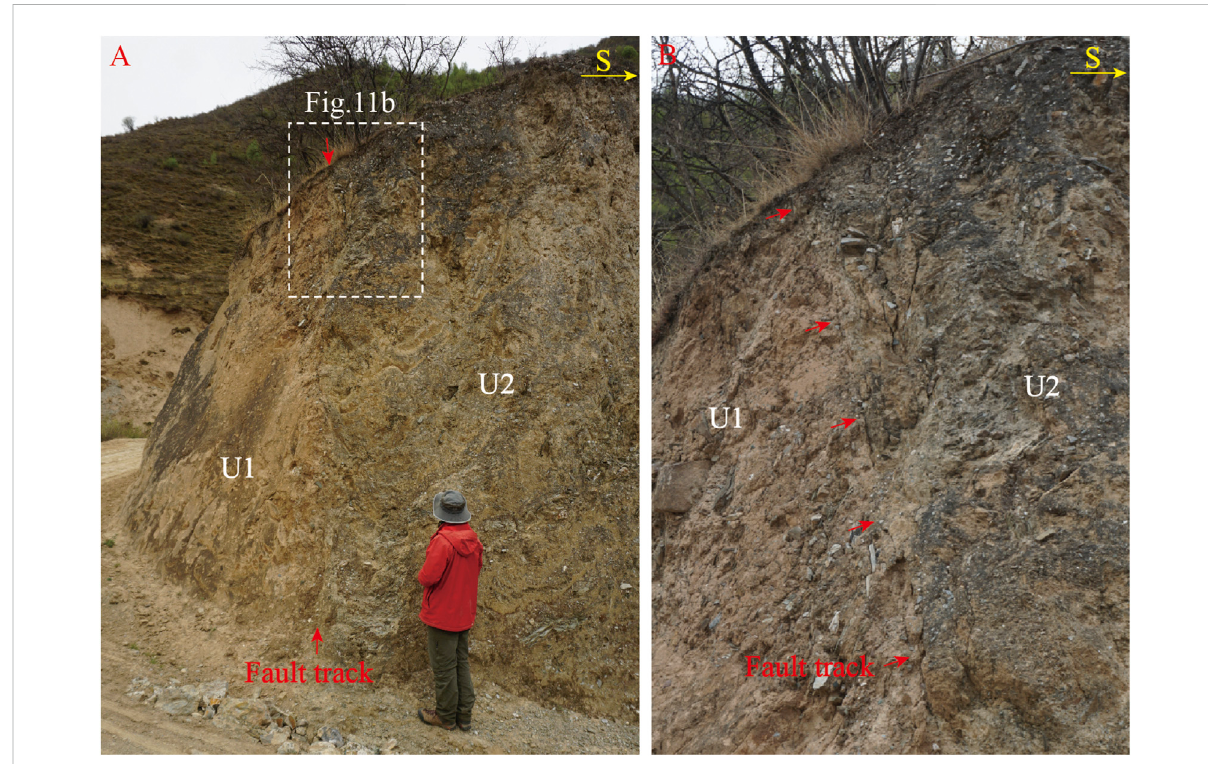
FIGURE 11 Fault outcrop of the Maisu fault near Yongqu, close to Gangtuo (E98.51560 ° , N31.71525 ° ). (A) Photograph showing the fault outcrop, unit U1 is composed of alluvial sand – gravel, and unit U2 is composed of tectonic breccia and clasticrock from the fault zone. (B) Close-up photograph of the area shown by the dashed rectangle in panel